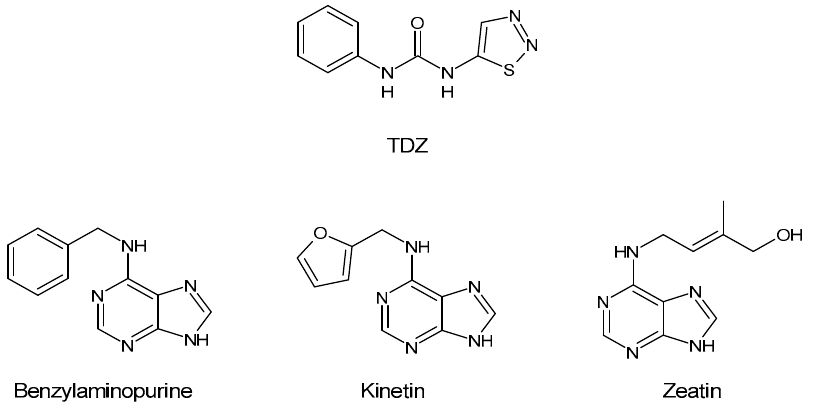
Figure 1. Structure of TDZ and other cytokinins.